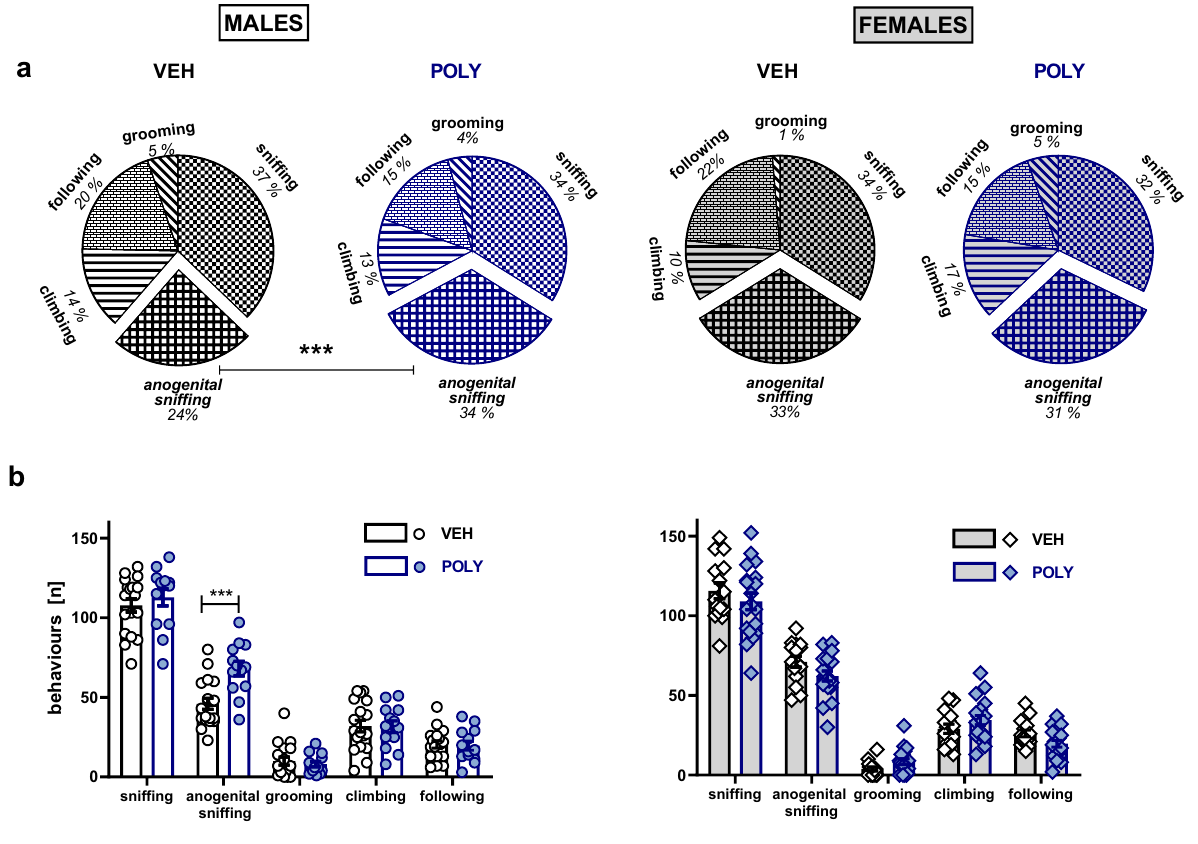
Figure 1. Behavior during the social interaction test. Poly(I:C) exposure increased the time ( a ) and the number of episodes ( b ) of anogenital sniffing in male rats. Data are presented as the percentage of time spent on a given behavior ( a ) and a mean ± SEM of the number of episodes of a given behavior ( b ). Symbols: ***p < 0.001, a significant difference between vehicle- and poly(I:C)-exposed males (planned comparisons).